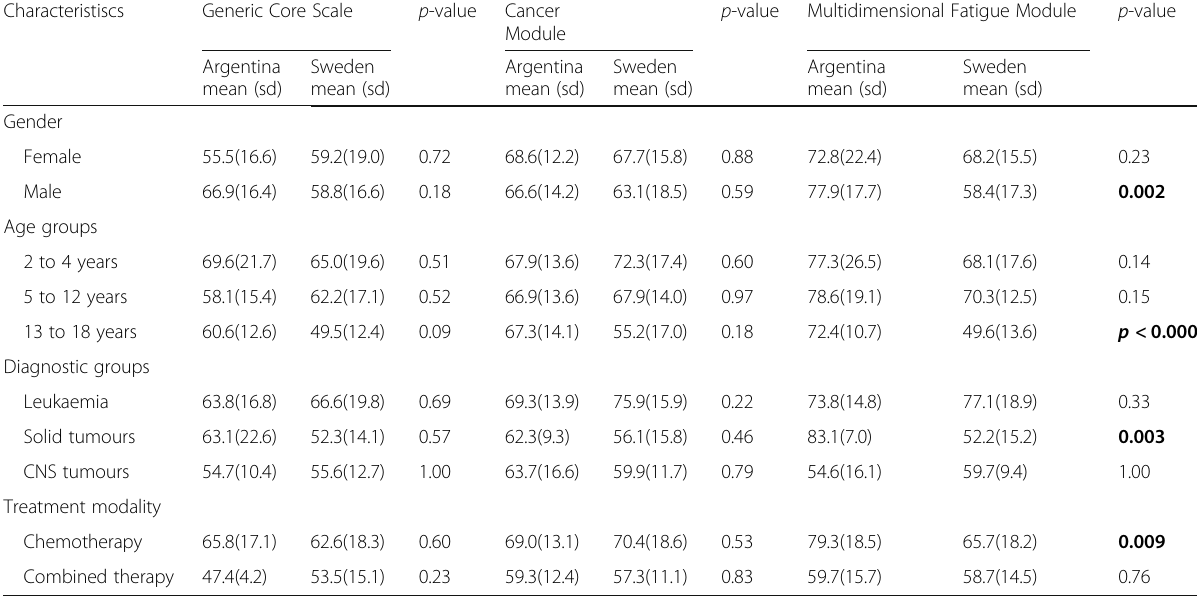
Table 3 PedsQL ™ , parents ’ /proxy self-reports: comparison between Argentina and Sweden